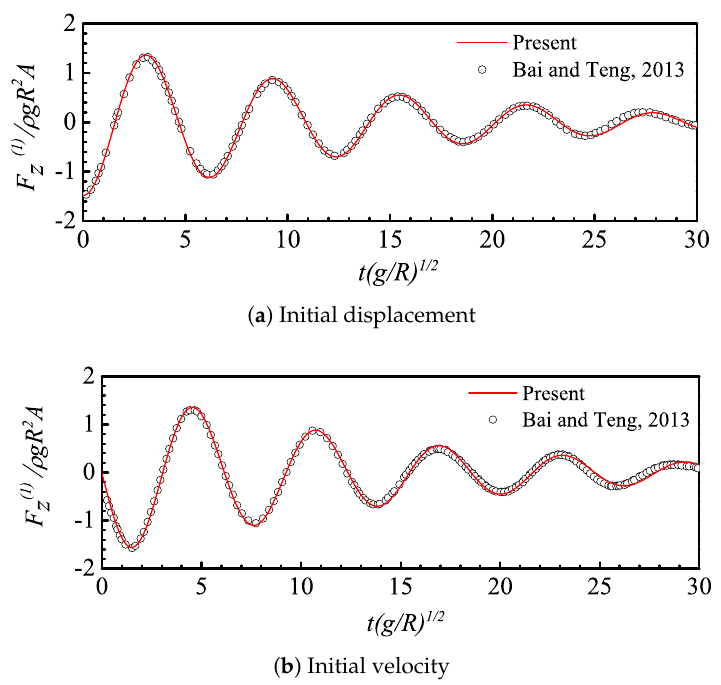
Figure 6. Time history of hydrodynamic force on a freely floating truncated vertical cylinder specifying initial